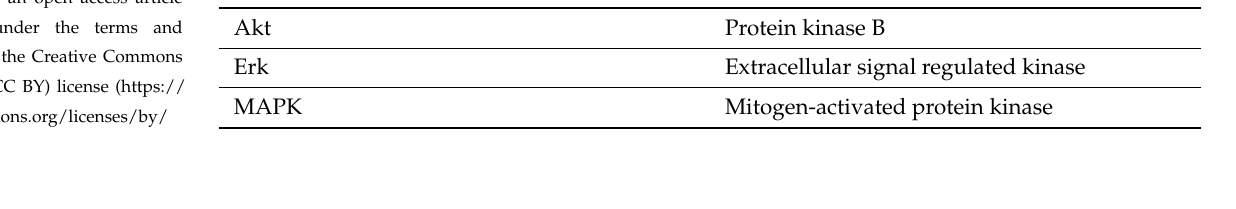
Table 1. List of abbreviations used in this